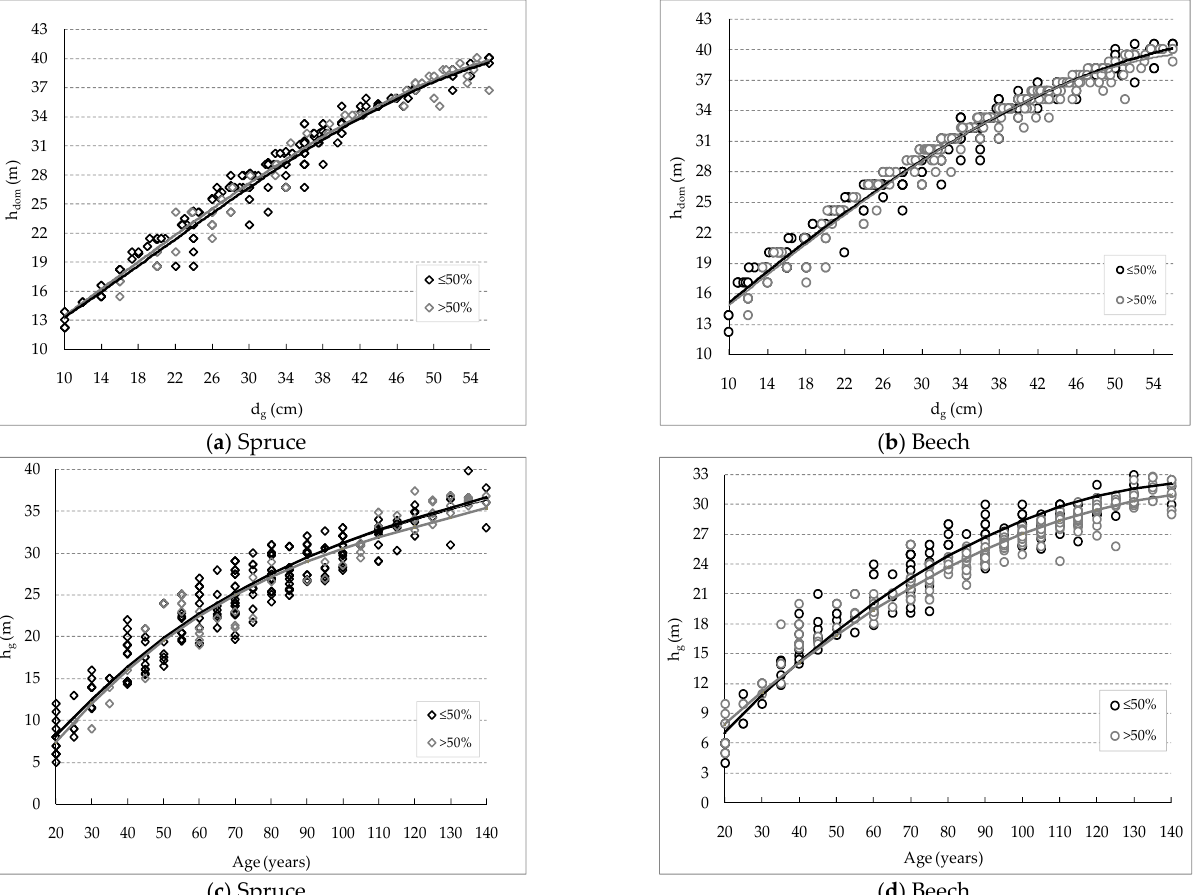
Figure 3. Variation in h dom in relation to diameter in: ( a ) spruce; and ( b ) beech; and h g in relation to age in: ( c ) spruce; and ( d ) beech in mixed stands in which the species occurred in mixtures with a p sp of between 10 and 90%.